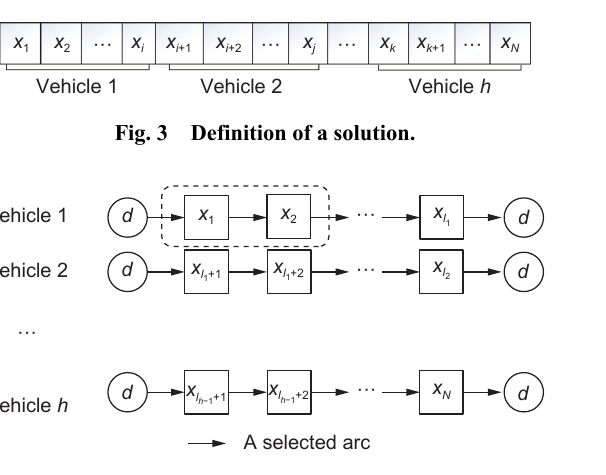
Fig. 4 Illustration of a solution after